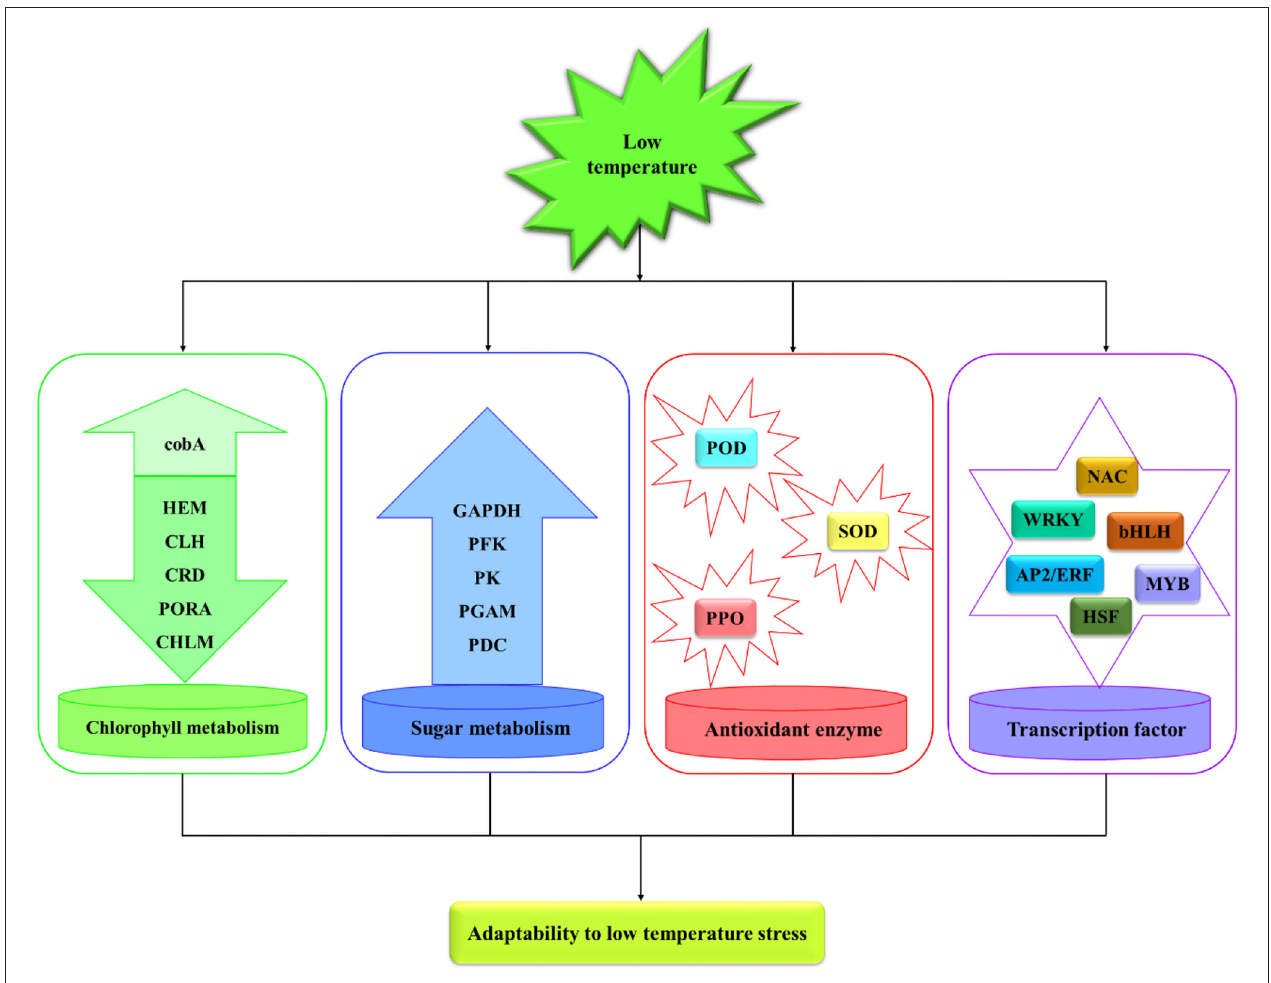
FIGURE 9 | Regulation network model in M. microcarpa leaves under low-temperature